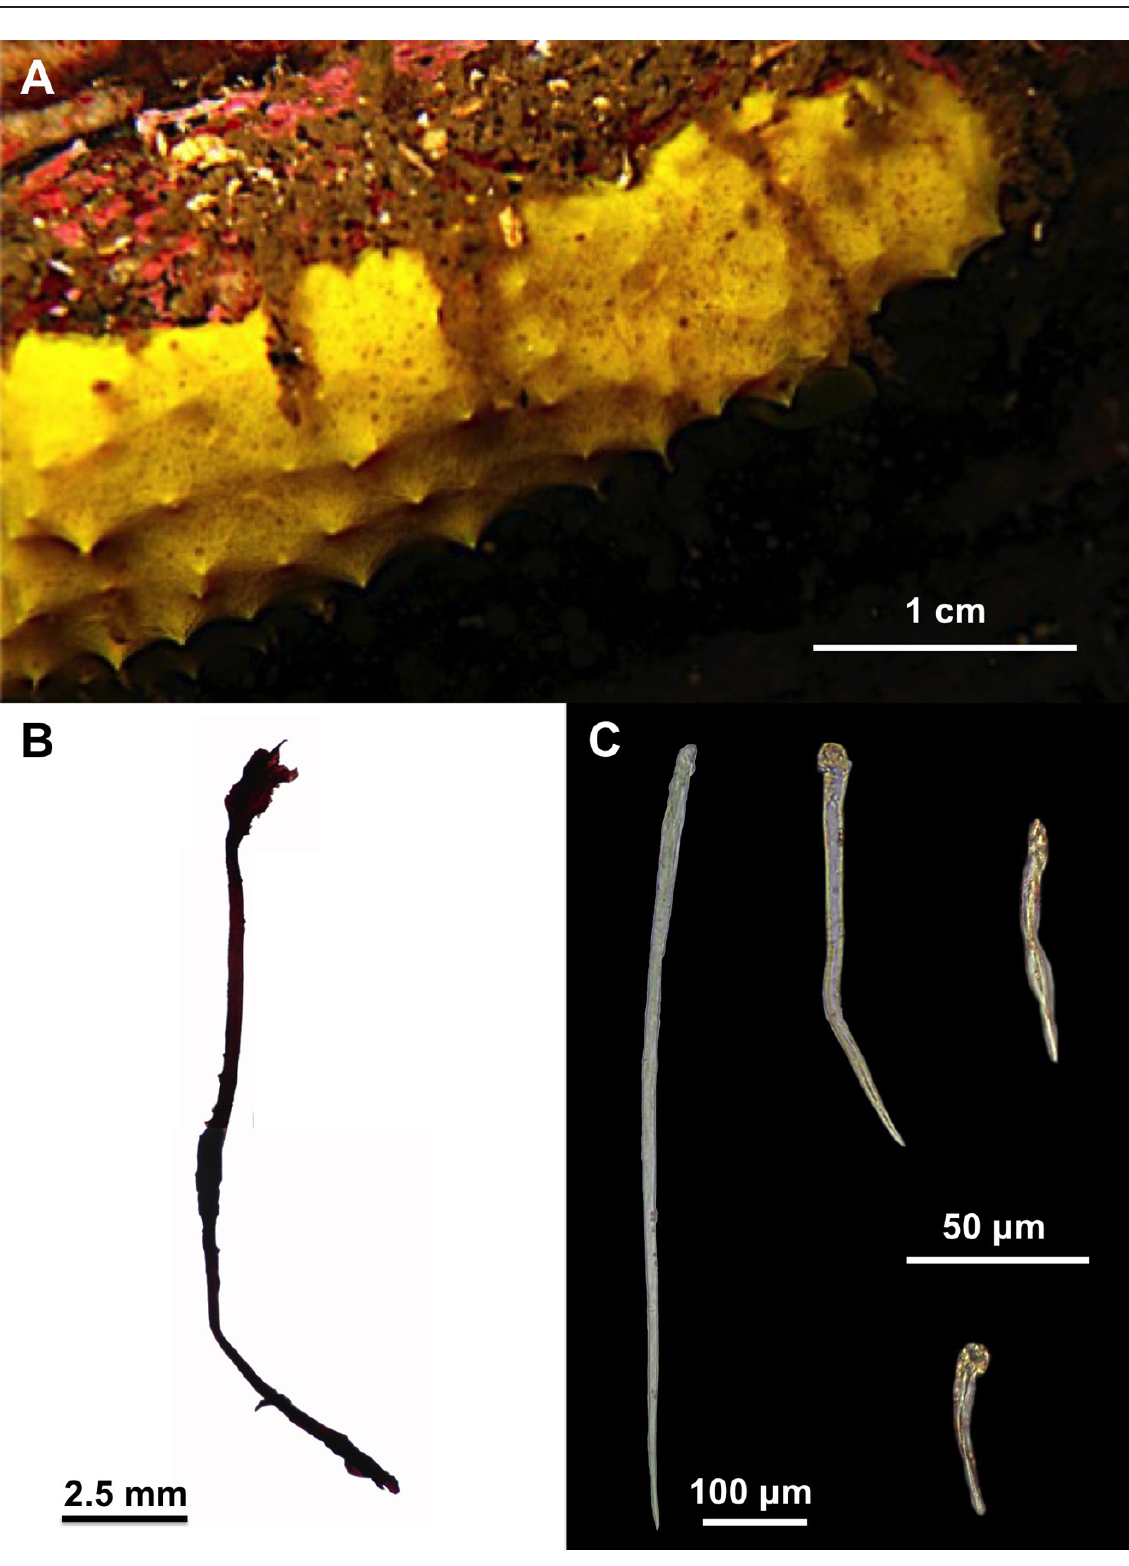
Fig. 15. Darwinella pronzatoi Bertolino, Costa & Pansini sp. nov., holotype (CILE 100; MSGN 61500). A . The holotype in life. B . Dendritic fibres. C . Horny